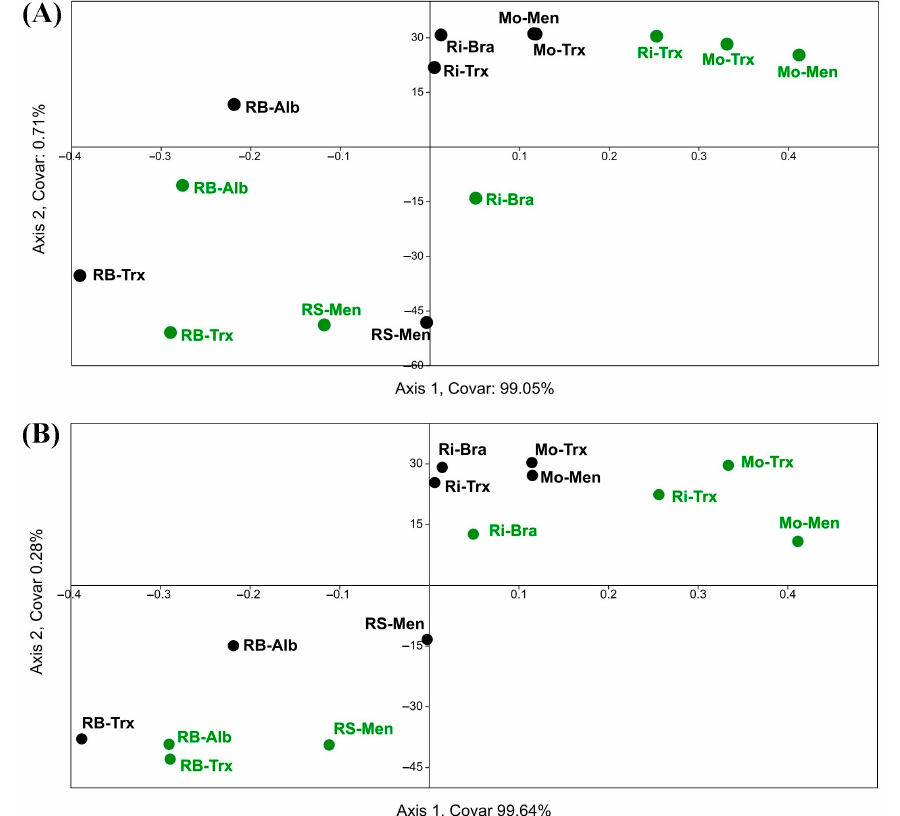
Figure 10. TB-PLS of the correlation between NDVI calculated using Sentinel-2 and Landsat-8 imagery at different dates and regional yeast diversity at frequency level (percentage or proportion of species) in the DOs (Monterrei, Mo; R í as Baixas, RB; Ribeira Sacra, RS; Ribeiro, Ri) according to organic (in green) and conventional production system (in black), and cultivars (Albariño, Alb; Brancellao, Bra; Menc í a, Men; Treixadura, Trx) in ( A ) grapes and ( B ) musts.